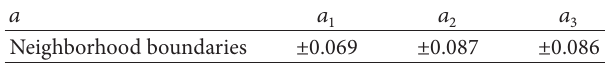
Table 5: An example of adaptive neighborhood boundary vector.